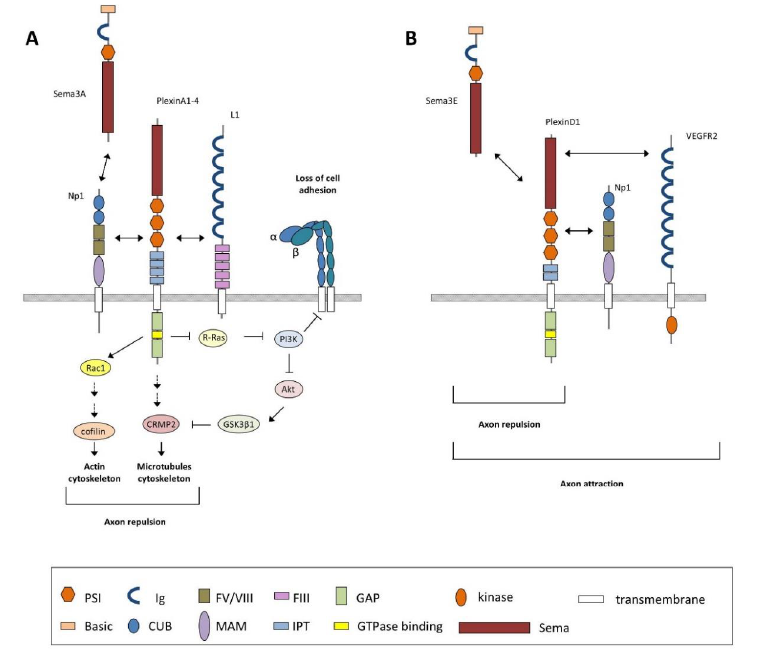
Figure 4. Schematic diagram depicting the main signaling mechanism described for class 3 semaphorins discussed in text (i.e., Sema3A). ( A ) Sema3A-mediated functions are triggered by its interaction with the Np1–PlexinA receptor complex, which promotes the activation of PlexinA through its GAP domain leading to the inactivation of the monomeric G-protein R-Ras and the activation of Rac1. The decrease in active R-Ras downregulates phosphoinositide-3 kinase (PI3K) activity and triggers Akt and GSK3β1 activity, leading to changes in microtubule dynamics. PI3K inactivation also inhibits integrin-mediated cell adhesion to extracellular matrix components. Activation of Rac1 promotes the sequential activation of several GTPases and GTPase-exchange factors (GEFs) such as RhoA, ROCK, and Lim kinases (not shown) to control actin dynamics. Modifications in the cytoskeleton, both in actin and microtubule dynamics, convey decreasing growth cone adhesion, allowing collapse responses. The Np1–PlexinA receptor complex also requires the interaction with Ig-superfamily cell adhesion molecules such as L1 to mediate neuronal functions. ( B ) Unlike other class 3 semaphorins, Sema3E directly binds plexinD1 to induce axon repulsion but induces axon attraction by binding a trimeric receptor complex, namely, Np1-PlexinD1-VEGFR2. Domain abbreviations: CUB = complement binding; FIII = fibronectin type III; FV/VIII = coagulation factor; GAP = GTPase activating protein; Ig = Immunoglobulin-like; IPT = Ig-like Plexin transcription factors; MAM = Meprin, A5, and receptor protein tyrosine phosphatase µ; PSI = plexin-semaphorin- integrin; Sema = semaphorin. 6. Involvement of Semaphorins in Neuronal Disorders Growing evidence suggests that semaphorins, their receptors, and also their intracellular signaling components are involved in epilepsy and some neurodegenerative disorders. Epilepsy includes a variety of different neurological disorders characterized by the predisposition to recurrent unpredictable seizures caused by disturbances in the electrical activity of the brain. These failures come from abnormal synaptic connections originating during brain development but also triggered